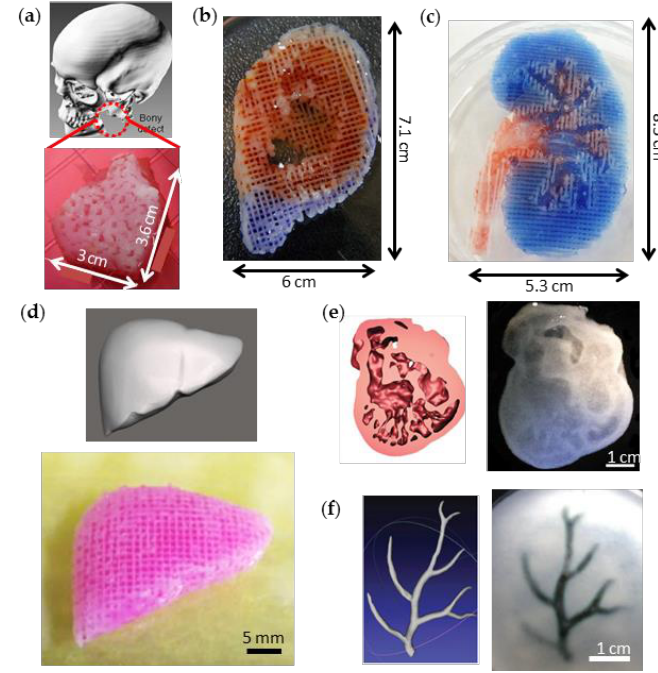
Figure 1. 3D printing of biological constructs with heterogeneous and complex structures. Photographs of the 3D-printed ( a ) a mandible bone construct, ( b ) an ear cartilage with ear lobule, ( c ) a kidney with renal pelvis, ( d ) a liver, ( e ) a heart cross-section, and ( f ) an arterial tree. Reproduced with permissions from [18,19,21,22,24].